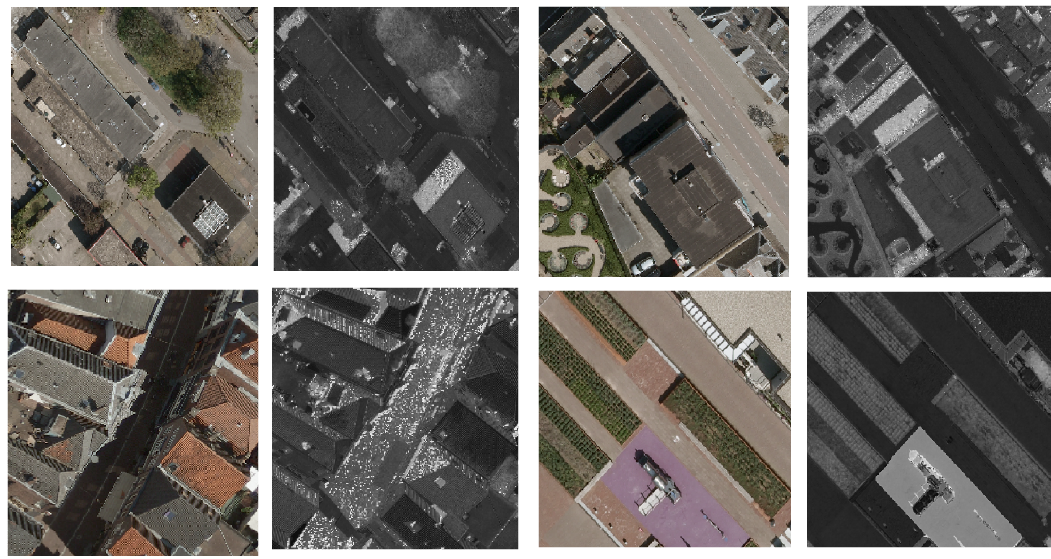
Figure 4. Four cases are displayed in RGB and ratio domain. In radio image, shadows are more white. The images in upper row shows that roofs are easily detected in ratio domain, while the images in lower row shows that shadow in city canyon and purplish objects can be correctly detected in RGB